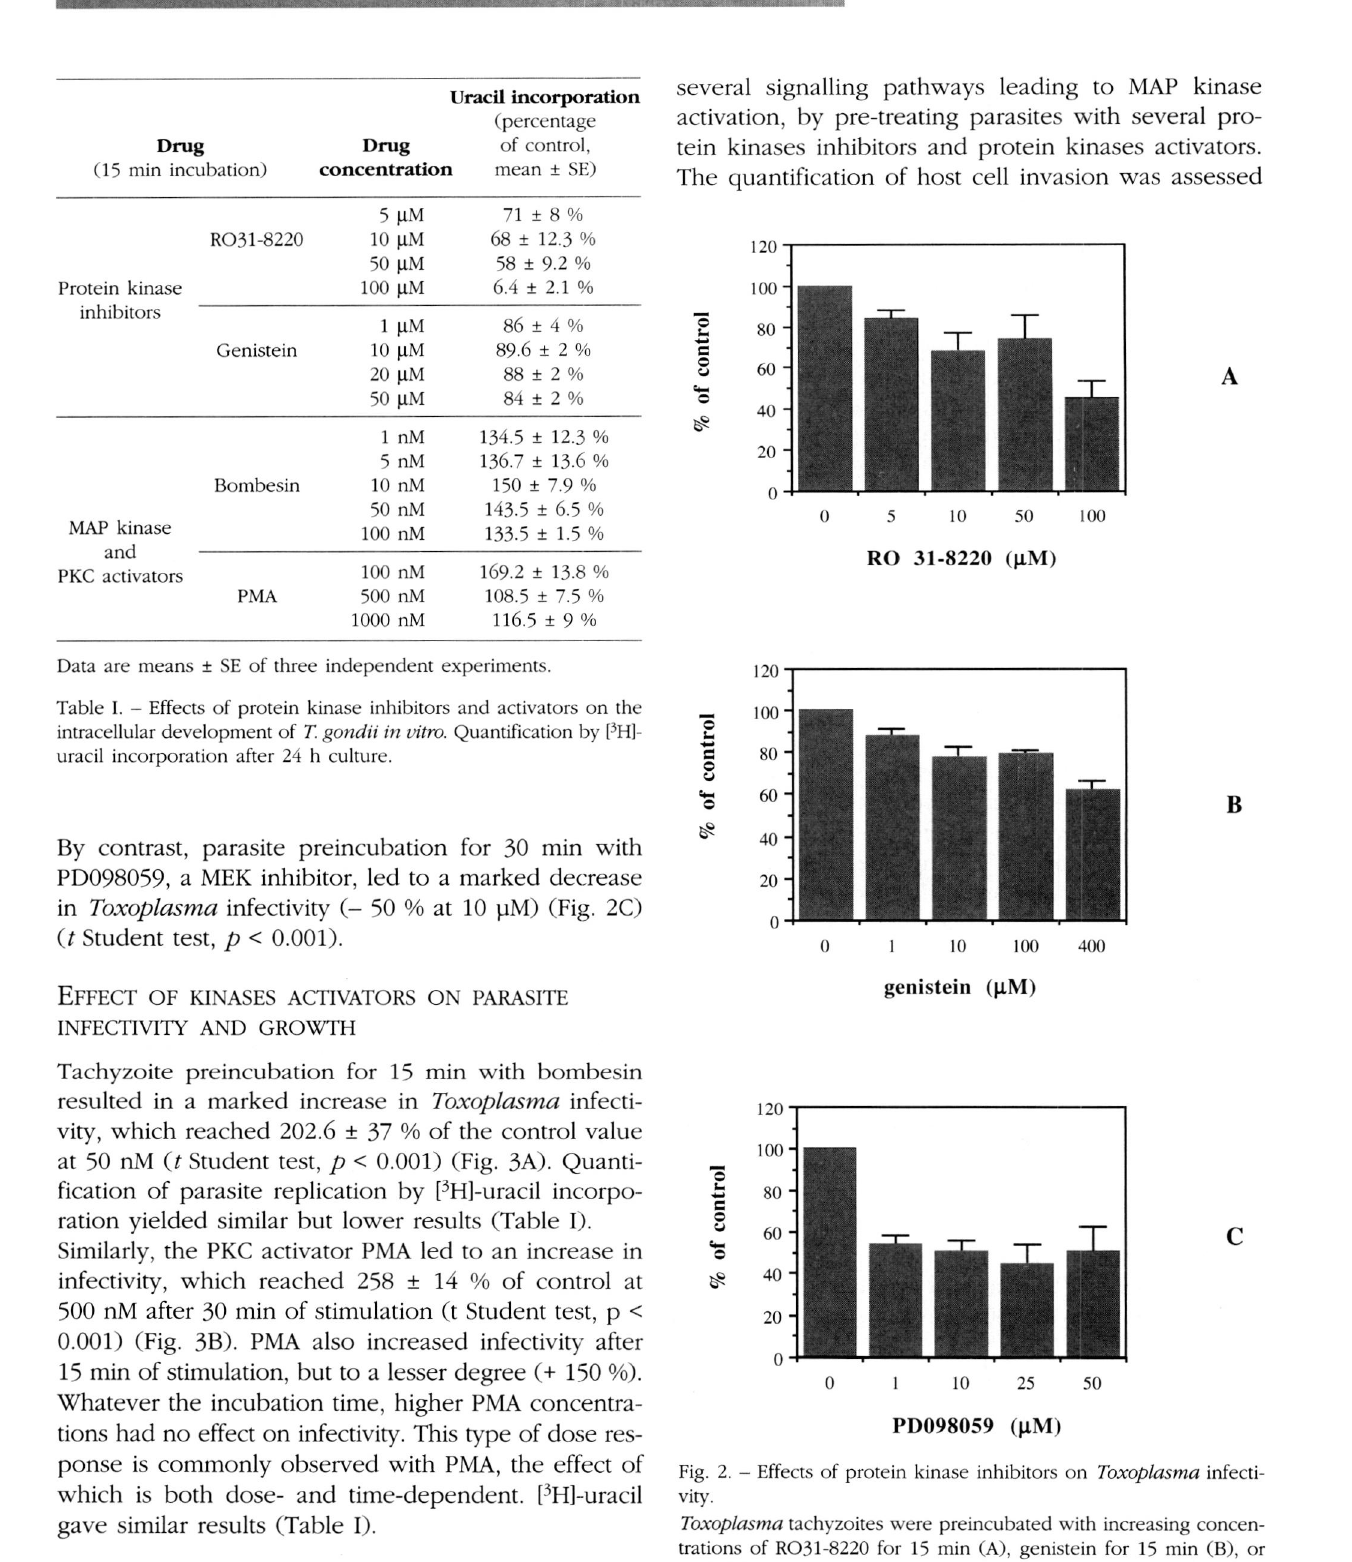
Fig. 2. - Effects of protein kinase inhibitors on Toxoplasma infecti- vity. Toxoplasma tachyzoites were preincubated with increasing concen­ trations of RO31-8220 for 15 min (A), genistein for 15 min (B), or PD098059 for 30 min